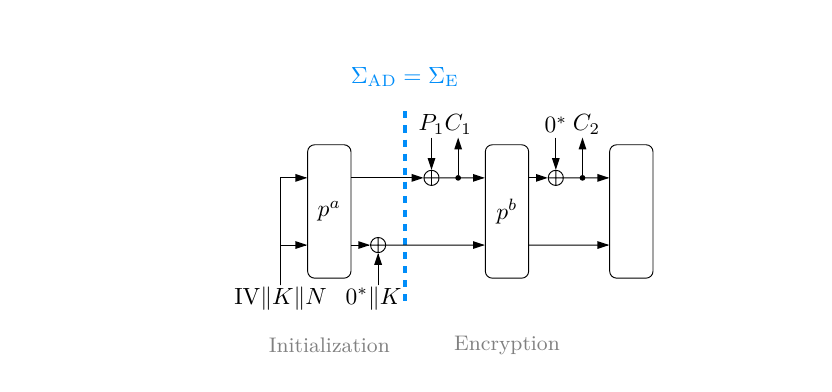
Figure 5: Nonce-misuse attack